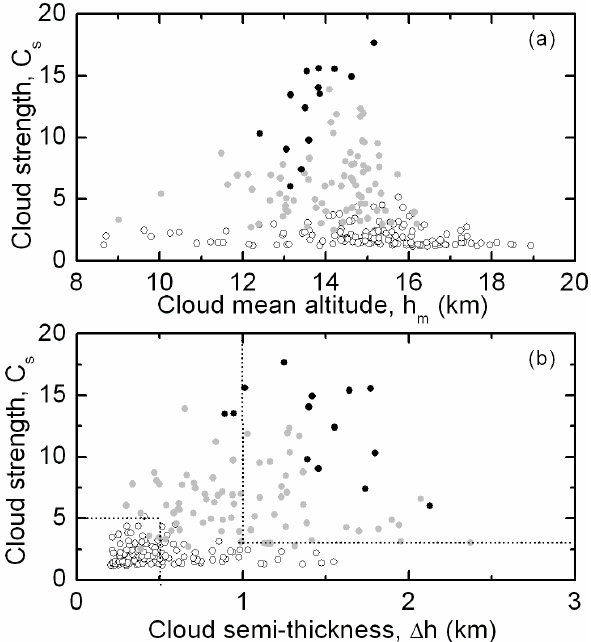
Fig. 9. Scatter plots showing the dependence of mean cloud strength Figure 9 ( C s ) on cloud mean altitude ( h m ) and cloud semi-thickness ( 1h ) for tropical cirrus.